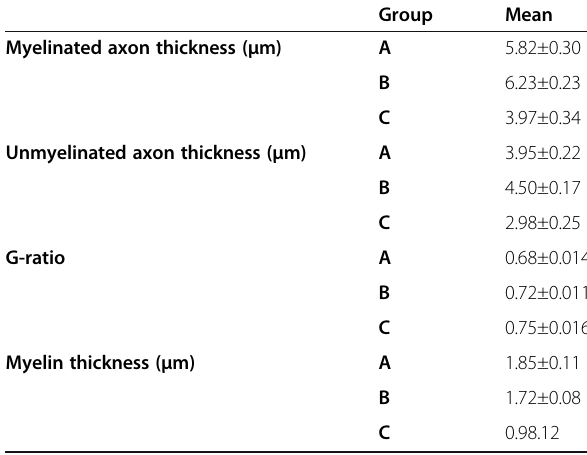
Table 2 Myelinated axon thickness, unmyelinated axon thickness, G-ratio, and myelin thickness in groups A (sham), B (0.7 N tension stretch), and C (1.5 N tension